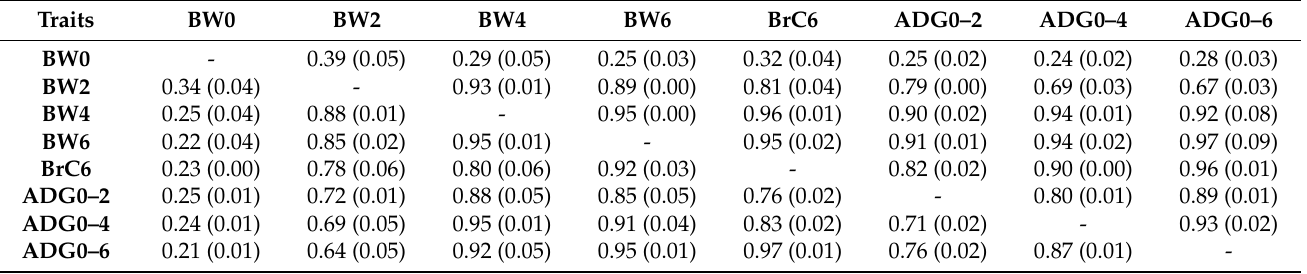
Table 4. Genetic correlations (standard error) in the KKU1 (above diagonal) and KKU2 (below diagonal)